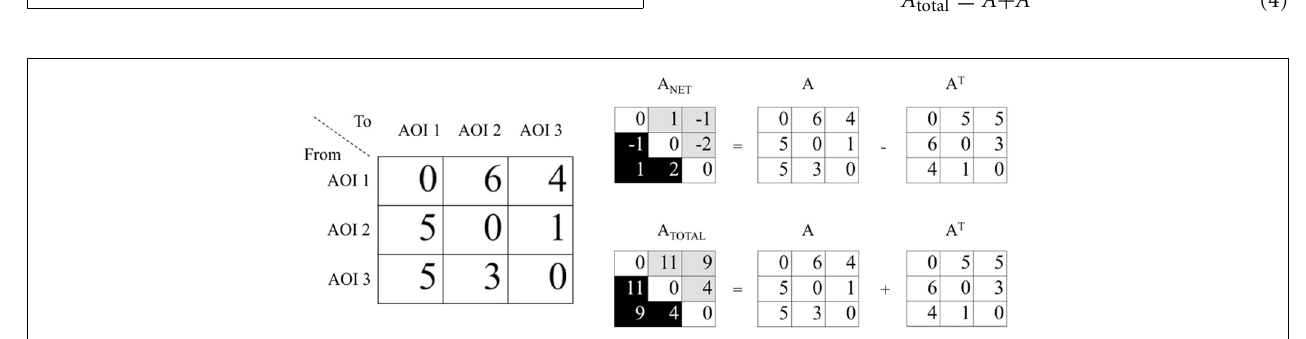
second column of A net denotes 2 transitions from AOI nr 3 to AOI nr 2. The negative number in the second row, first column denotes one transition from AOI nr 1 to AOI nr 2 (negative number reverses the direction). The black cells in A total describe the total number of transitions between three